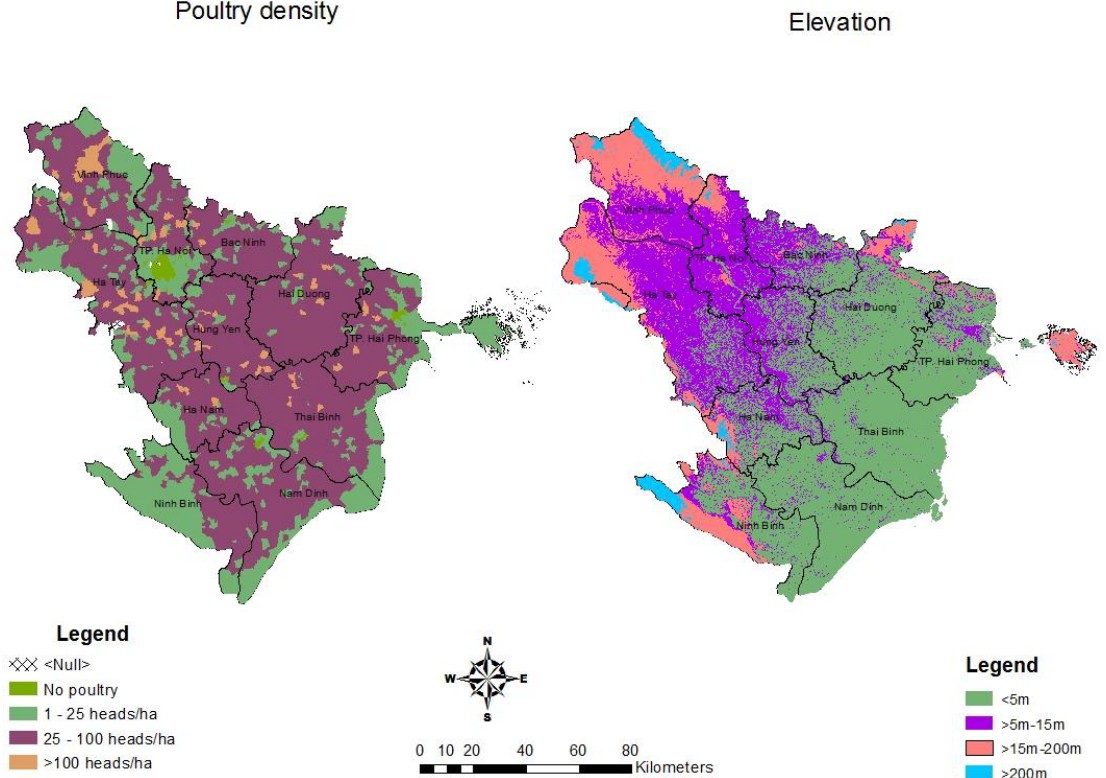
Figure 2. Spatial distribution of poultry density and elevation in the Red River Delta.